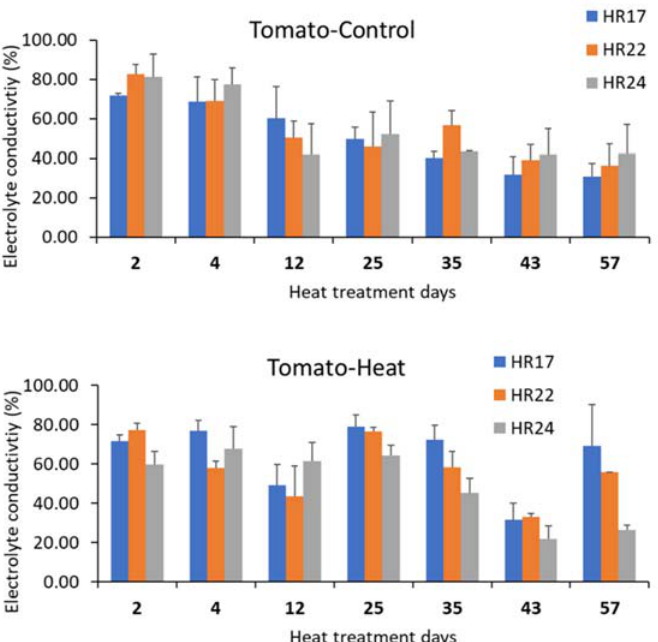
Figure 5. Effects of heat stress on leaf electrolyte leakage rate of three cherry tomato accessions for a long ‐ term period in heat stress treatment and control greenhouses. Table 5. Nitrogen Use Efficiency (NUE, %) and relative ratios of fruit and biomass NUE of three cherry tomato accessions grown in heat ‐ treated and control greenhouses for 35 days and 57 days. ANOVA of effects of treatment days, heat stress, accessions, organs (biomass and fruit), and their interactions on NUE were presented. n.s. indicates no significant difference. * indicates the interac ‐ tion between variables.